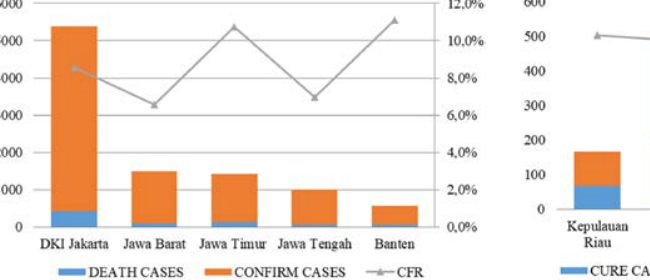
Fig. 3. Five provinces with the highest cure rate in Indonesia